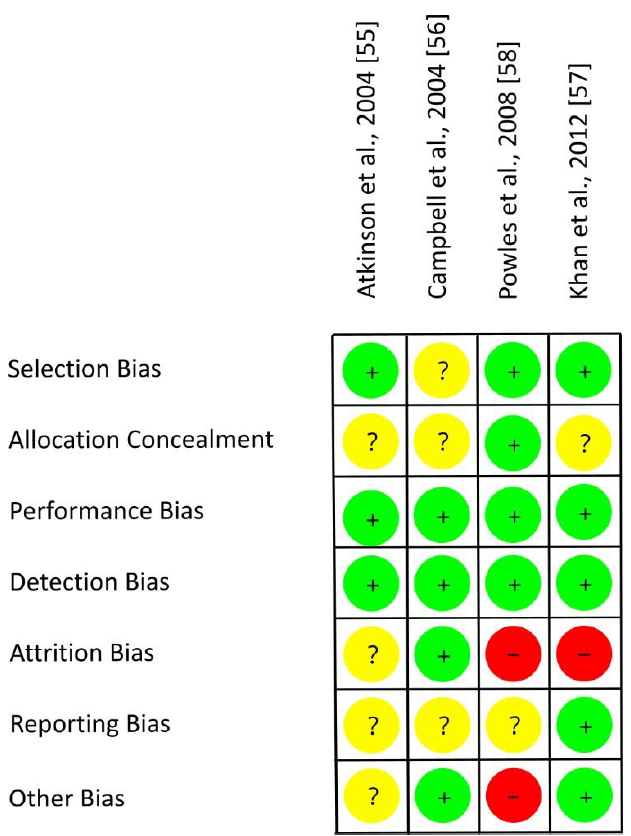
Figure 6. Risk of bias for studies with a mixed group of pre-, peri- and postmenopausal women. Green (+), low risk of bias; yellow (?), unclear risk of bias; red (−), high risk of bias.